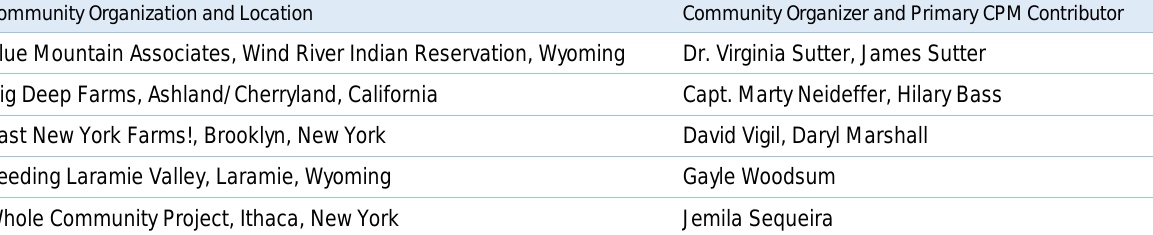
Table 1. Food Dignity Community Partner Organizations and Collaborative Pathway Modeling (CPM)